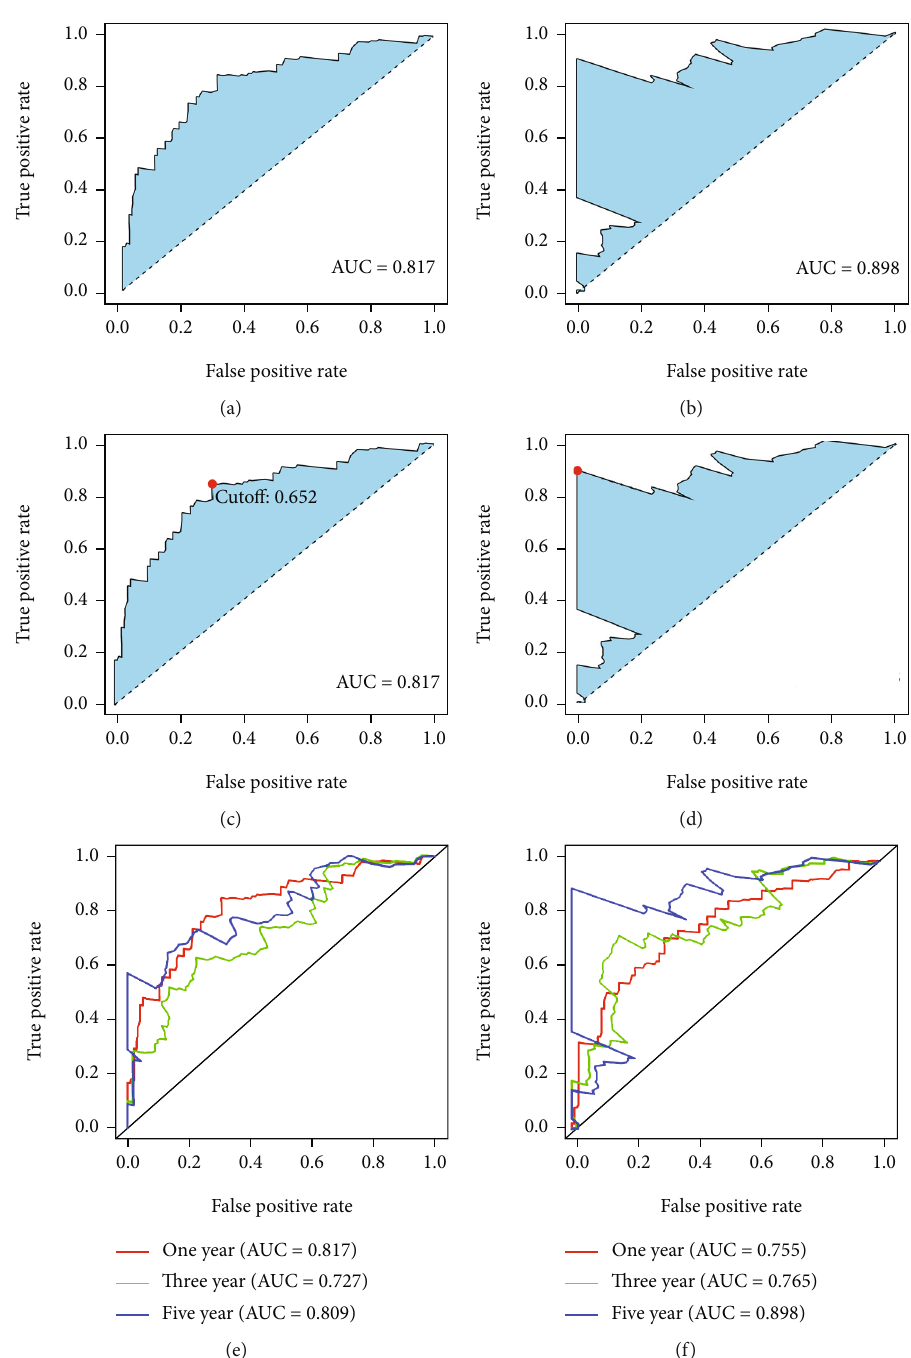
Figure 5: Inner validation of the risk model. Patients were random divided into two validation sets at a ratio of 5:5. The maximum AUC values of 5 years exceed over 0.8 in two validation sets ((a) and (b)). The maximum in fl ection point is the cut-o ff point ((c) and (d)). One year, three years, and fi ve years AUV value were exhibited, respectively ((e) and